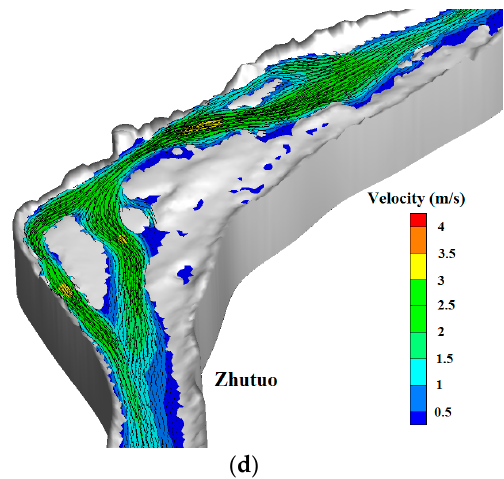
Figure 10. Flow velocity field on gauging stations along the Yangtze River during upstream water regulations: ( a ) Yibin; ( b ) Hejiang; ( c ) Luzhou; and ( d ) Zhutuo.